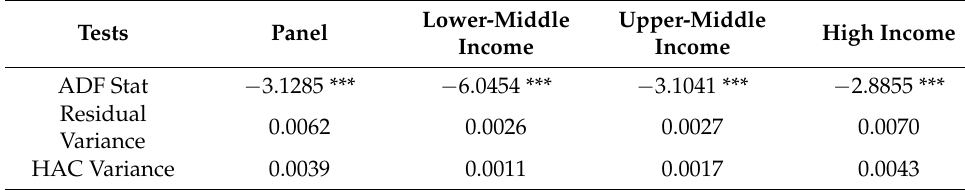
Table 3. Kao Test of Co-Integration.